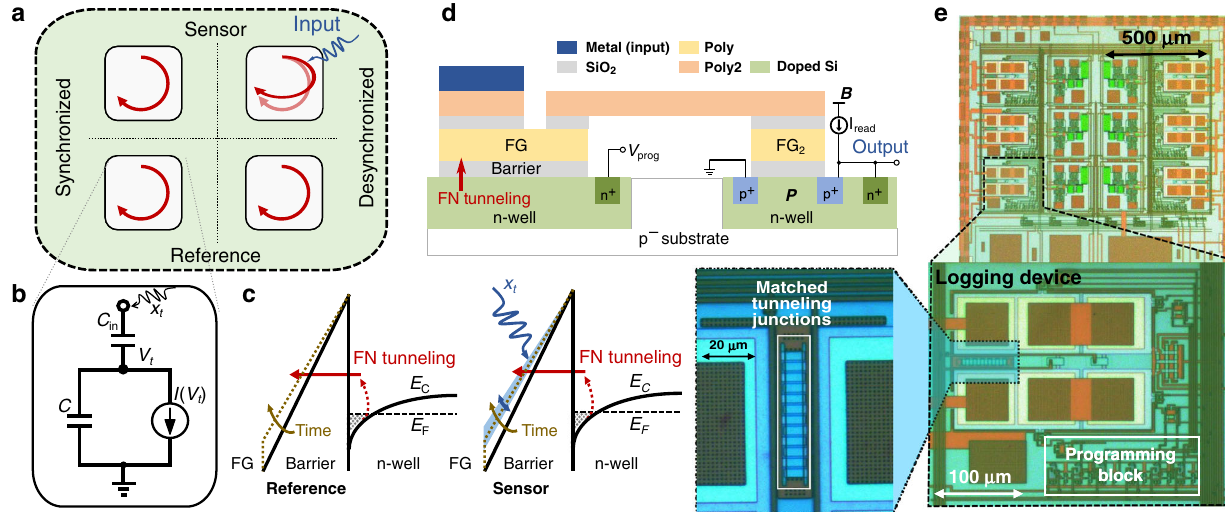
Fig. 1 Operating principle and architecture of the proposed sensor-data logger. a Principle of sensing and data logging where the input signal leaves its trace on a pair of synchronized dynamical system through a desynchronization process. b Equivalent circuit model of a self-powered dynamical system where the charge on a capacitor C stores the dynamical state of the system and the dynamics is governed by a leakage current I ( V t ) and ambient stimuli x t . c Band diagram corresponding to the tunneling junction where the electrons tunnel across the triangular energy barrier and the input signal x t modulates the barrier shape. d Cross-section of the sensor-data-logging device showing the FN tunneling junction, the fl oating gate which is coupled to a read-out transistor P and a buffer B . e Micrograph of the fabricated devices, with inset showing a pair of dynamical systems con fi gured in a differential